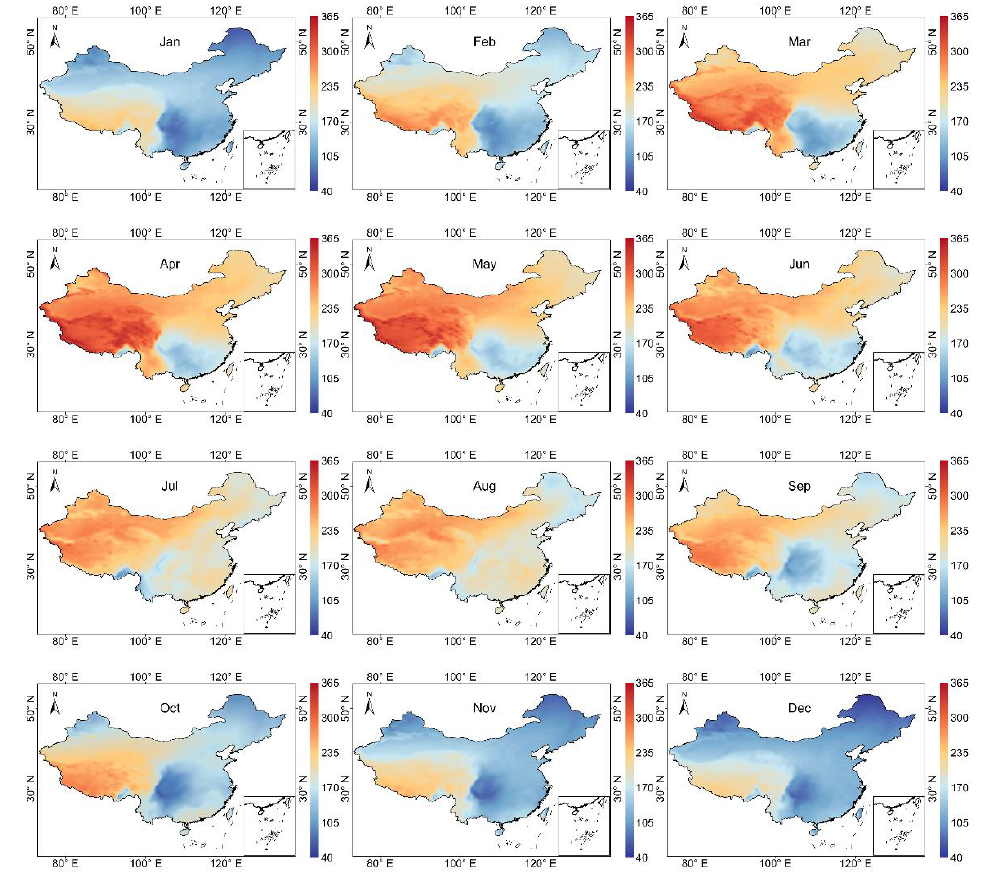
− 2 ) in China from 2010 to